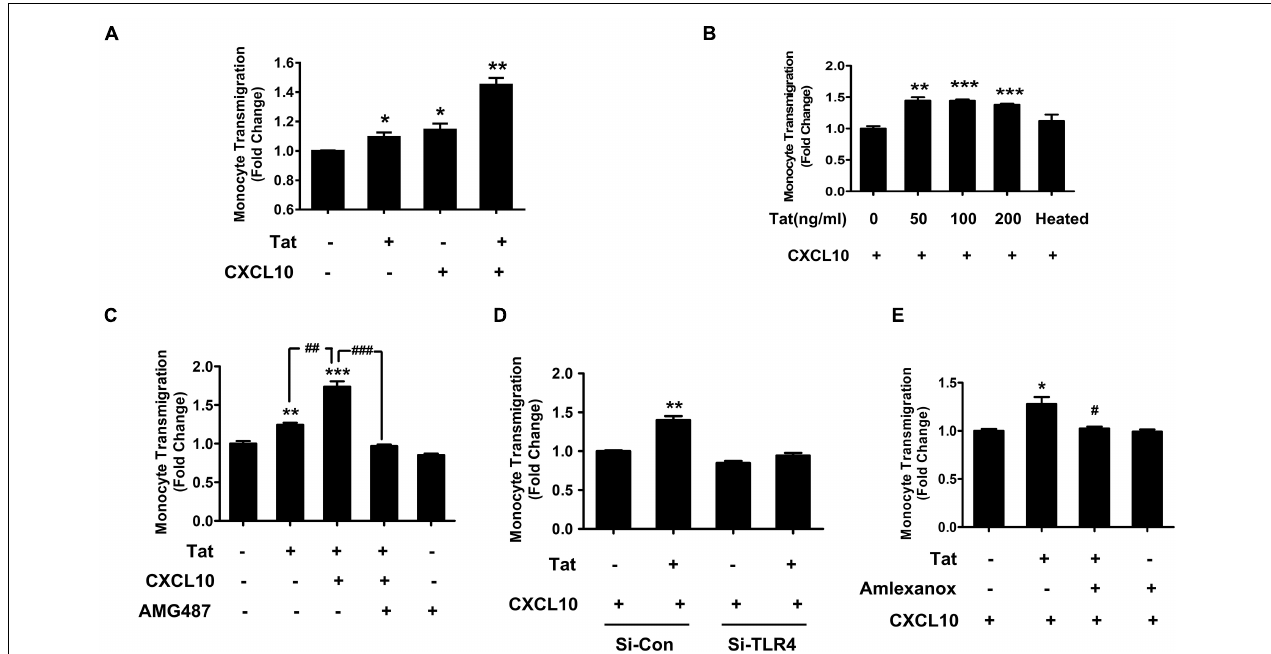
FIGURE 7 | HIV Tat-mediated upregulation of CXCR3 in human monocytes facilitated its transmigration in an in vitro BBB model. (A) Human monocytes were pretreated with/without HIV Tat, followed by the transmigration assay in response to control media or CXCL10 (100 ng/ml). N = 3. (B) Human monocytes were pretreated with various concentrations of HIV Tat (50, 100, and 200 ng/ml), followed by the transmigration assay in response to CXCL10. N = 3. (C) Pretreatment of monocytes with the CXCR3 antagonist AMG487 ameliorated HIV Tat-induced monocyte transmigration in response to CXCL10. N = 3. (D) Human monocytes were transfected with TLR4 siRNA and nonsense siRNA transfected controls (si-Con) followed by exposure of transfected cells to HIV Tat and transmigration assay in response to CXCL10. N = 3. (E) Human monocytes were pretreated with TBK1 inhibitor Amlexanox followed by HIV Tat exposure and transmigration assay in response to CXCL10. N = 3. One-way ANOVA with post hoc test. All data are presented as mean ± SD of three or four individual experiments (Biological replicates). * p < 0.05 versus control group; ** p < 0.01 versus control group; *** p < 0.001 versus control group; # p < 0.05 versus HIV Tat + CXCL10 group; ## p < 0.01 versus HIV Tat group; ### p < 0.001 versus HIV Tat + CXCL10